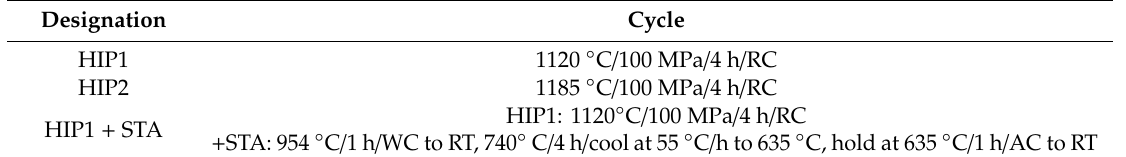
Table 3. Details of